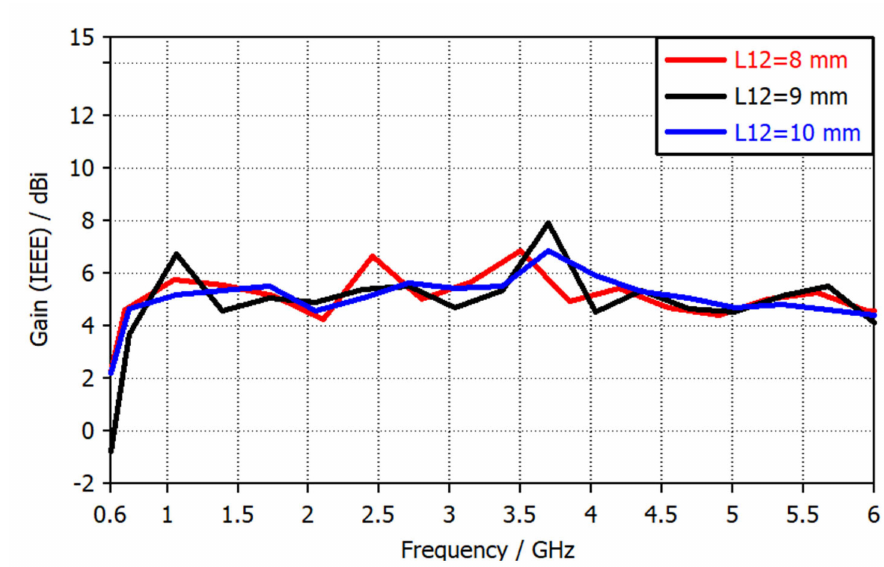
Figure 9. Simulated gain with different lengths of extra dipole.